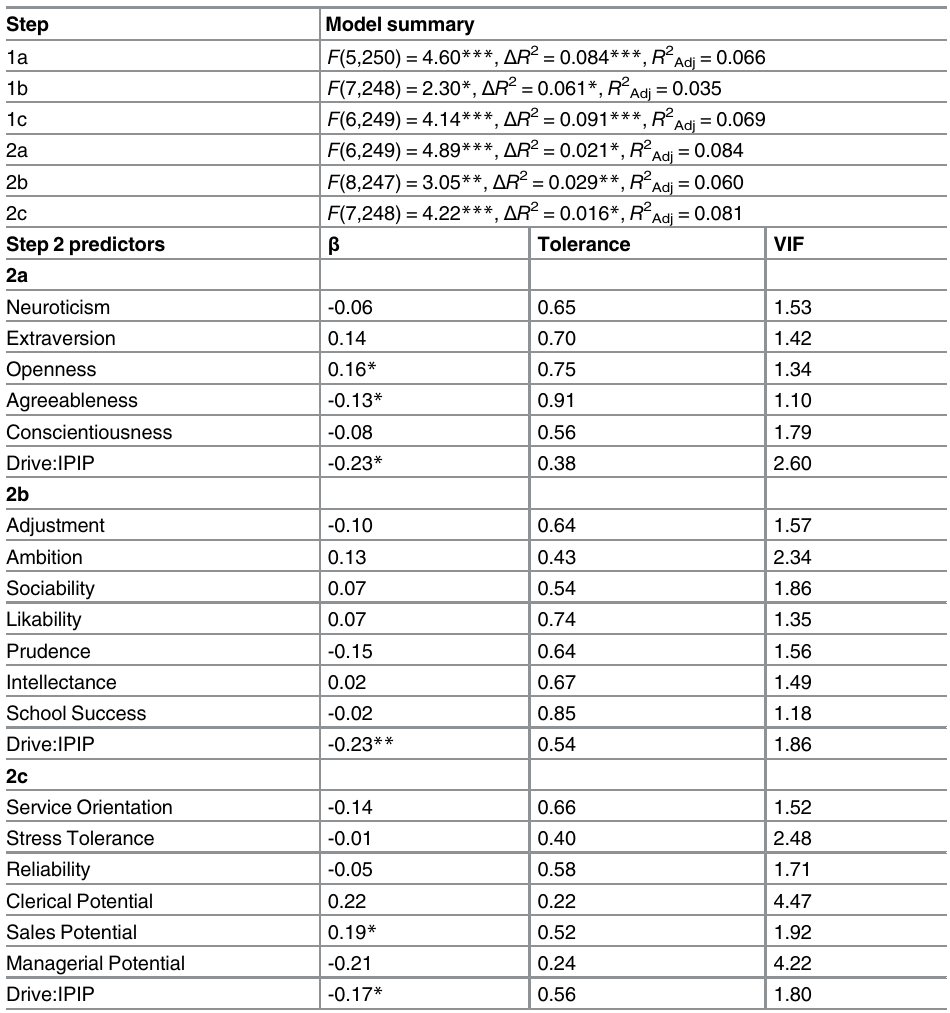
Table 12. Hierarchical Regression Analysis Predicting Work Avoidance with the NEO PI-R Domains (Step 1a), HPI Primary Scales (Step 1b), or HPI Occupational Scales (Step 1c) and the Drive:IPIP (Steps 2a, 2b, and 2c) in the Eugene-Springfield Community